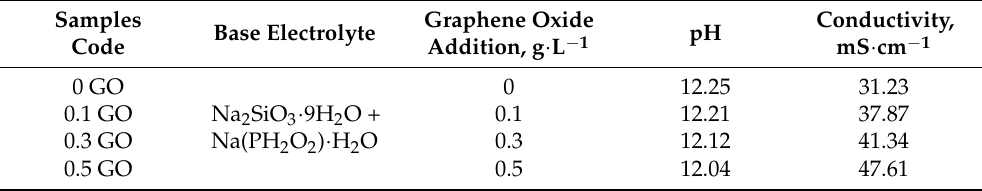
Table 2. The sample code and main technological parameters of MAO process.